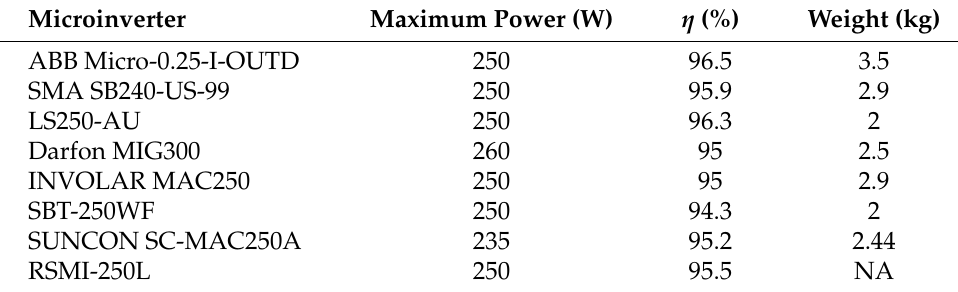
Table 1. Ratings of microinverters available in market